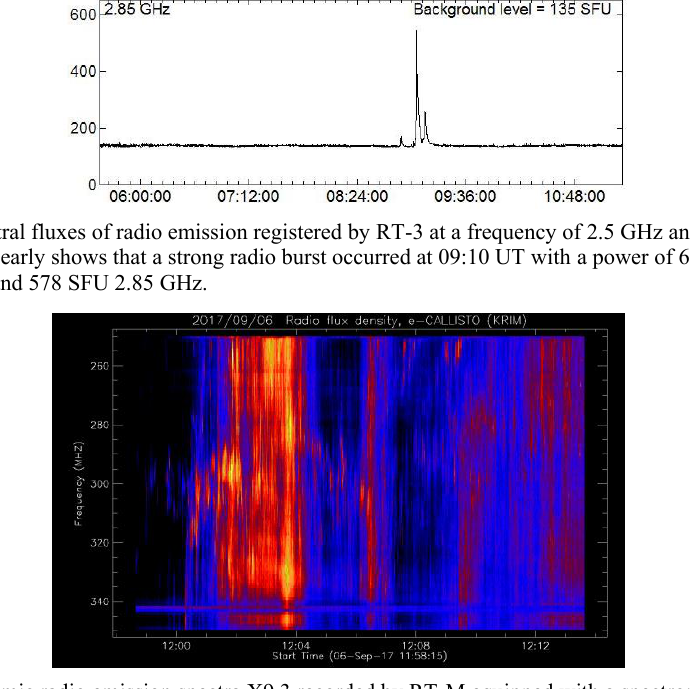
Fig. 4. Dynamic radio emission spectra X9.3 recorded by RT-M equipped with a spectrometer Callisto. Type IV radio